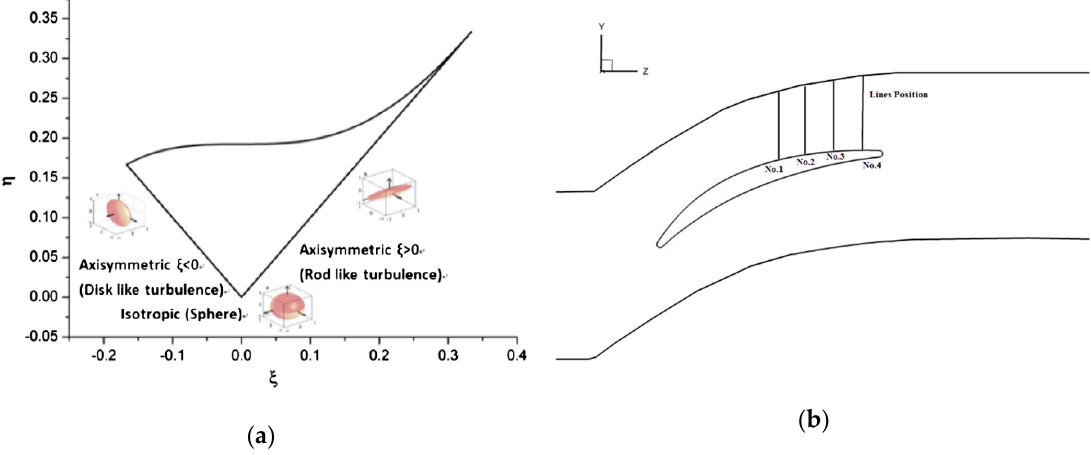
Figure 16. Lumley triangle and the position of the extracted line: ( a ) Lumley triangle; ( b ) position of